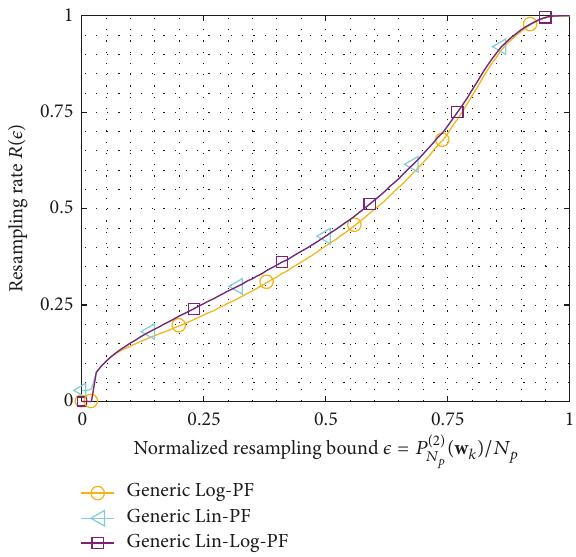
Figure 3: Performance evaluation of the Generic Log-PF, Generic Lin-PF, and Generic Lin-Log-PF by the resampling rate 𝑅(𝜖) versus the normalized resampling bound 𝜖 = 𝑃 (2) 𝑁